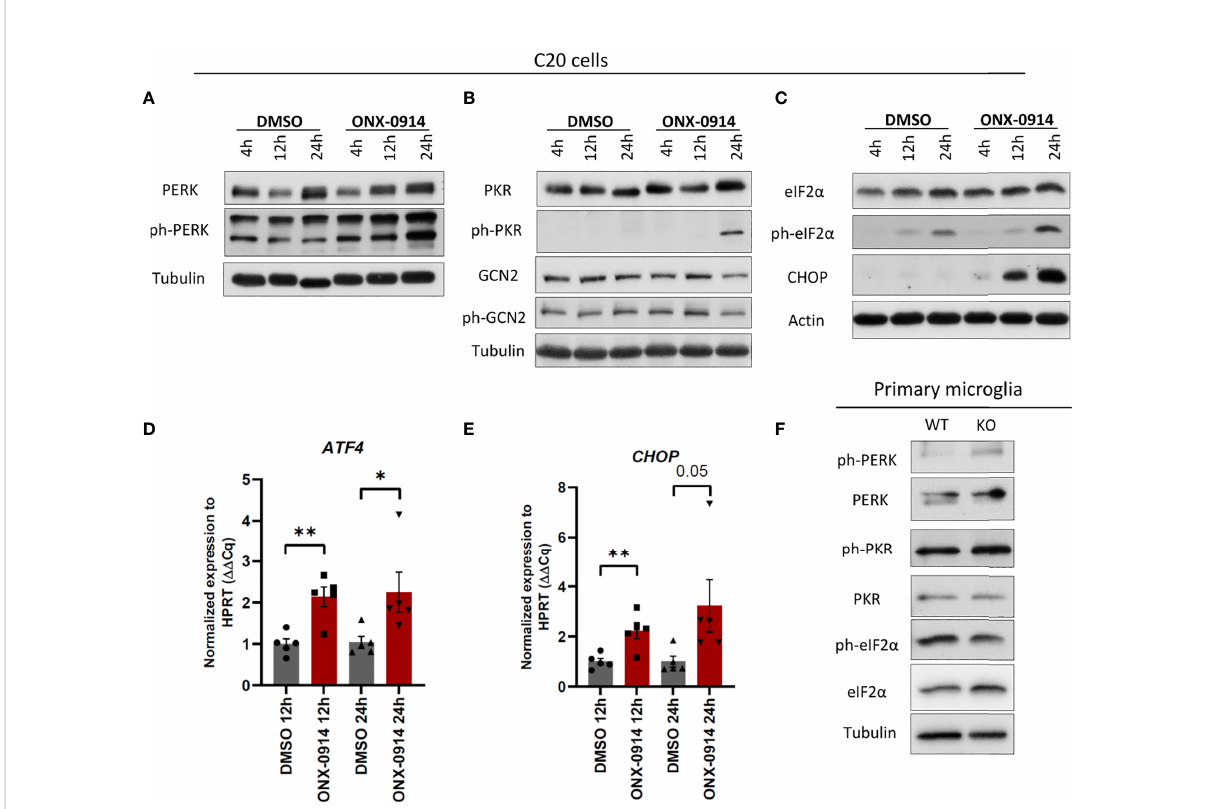
FIGURE 2 b 5i/LMP7 inhibition activates UPR/ISR in microglia. (A – C) Western blot analysis of UPR and ISR proteins in C20 cells treated with 200nM of ONX-0914 for indicated time (n=3). (D, E) Quantitative reverse transcription PCR (RT-PCR) analysis of ATF4 (D) and CHOP (E) mRNA levels in C20 cells treated with 200nM of ONX-0914 for indicated time (n=5). (F) Western blot analysis of UPR and ISR proteins in WT and b 5i/LMP7 KO primary microglia (n=3). Mean ± SEM; *: P < 0.05, **: P <